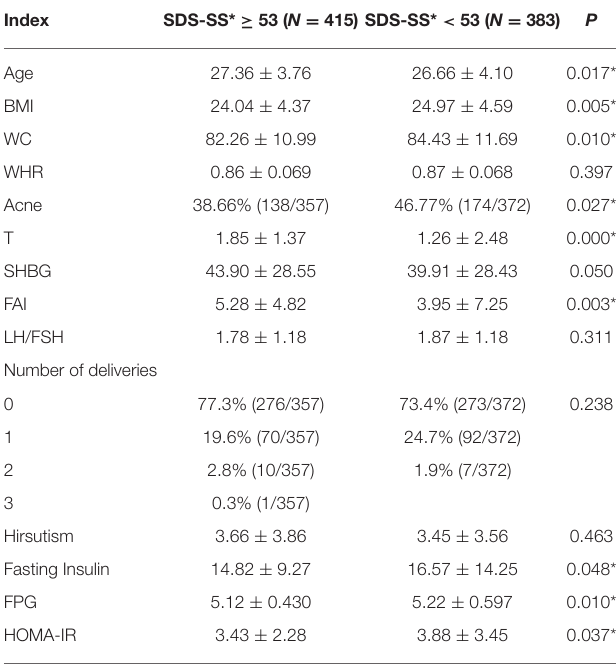
TABLE 1 | Baseline characteristics of women with PCOS with anxiety (SAS-SS ≥ 50) and without anxiety (SAS-SS < 50). Index